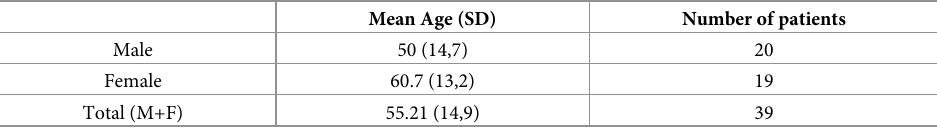
Table 9. Age and gender distribution of studied